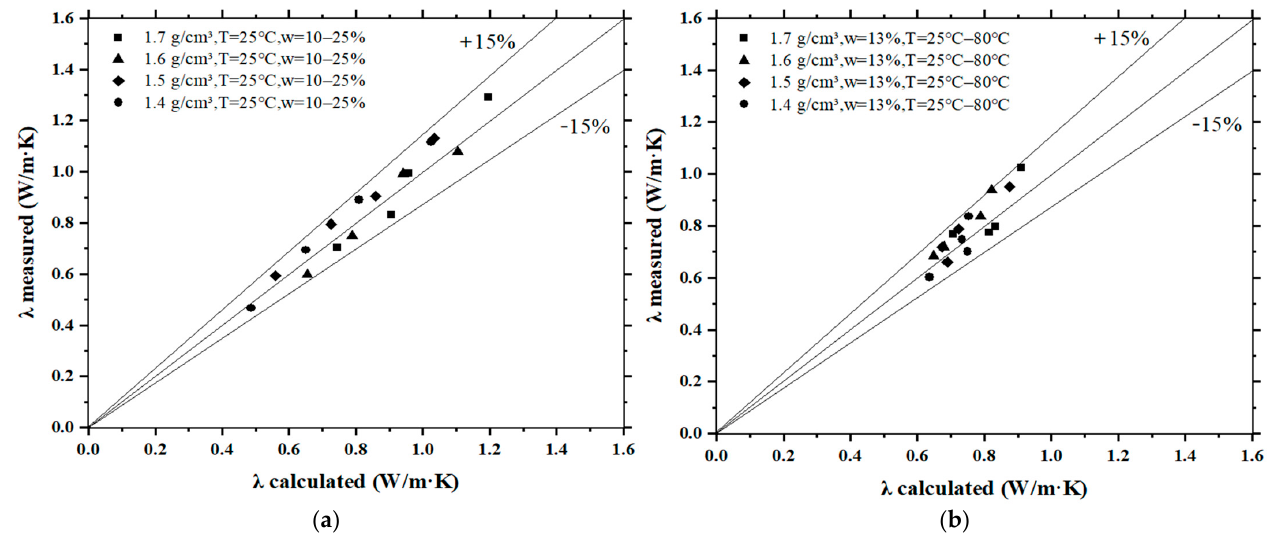
Figure 15. Comparison between the calculated and measured thermal conductivities ( a ) calculated by Equation (4) vs. measured; ( b ) calculated by Equation (5) vs. measured.